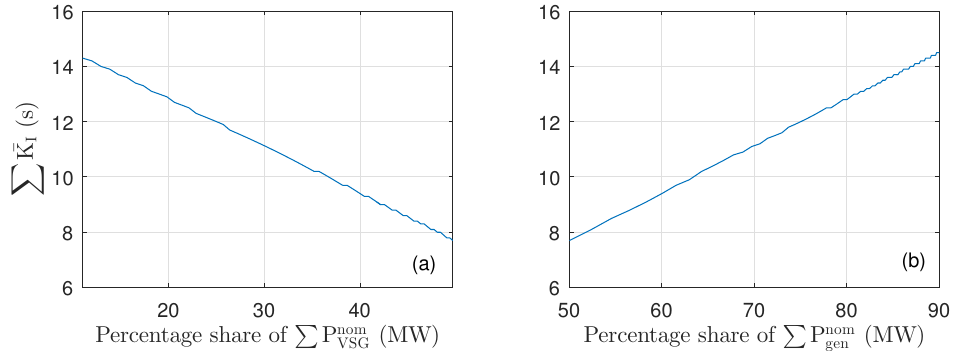
Figure 13. Cumulative virtual inertia gain as function of percentage share of VSG nominal power in ( a ) and of generator nominal power is shown in ( b ). The percentage share is to the total generation and VSG nominal power capacity. The f c of PLL is set to 40